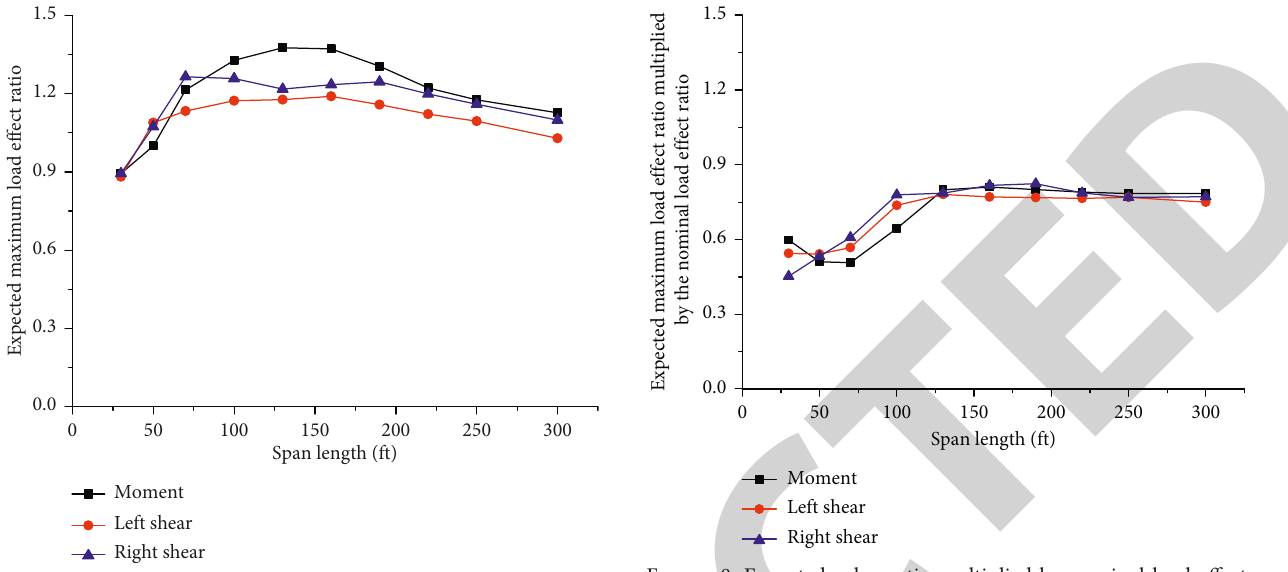
Figure 8: Expected value ratio multiplied by nominal load effect ratio in equation (8) for site 002 (with 10% allowance).